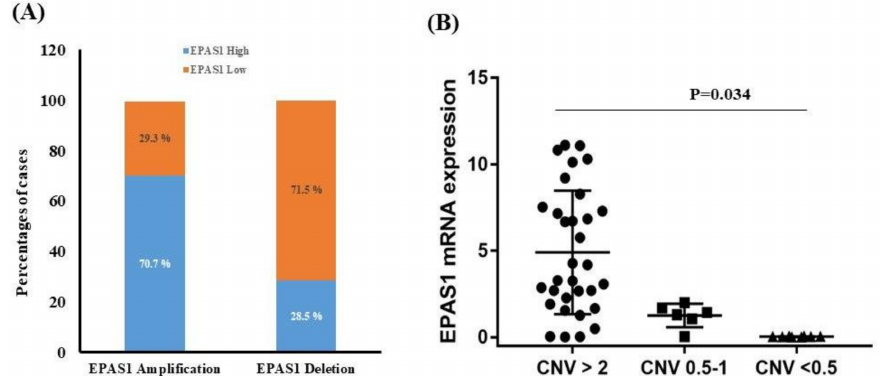
Figure 5. Relationship of EPAS1 DNA number alteration and mRNA expression. ( A ) Association of EPAS1 DNA number changes and mRNA expression. Quantitative reverse transcription polymerase chain reaction (RT-qPCR) analysis revealed that EPAS1 DNA number amplification significantly correlated with mRNA overexpression ( p < 0.009). ( B ) The distribution of EPAS1 mRNA expression in patients with phaeochromocytomas / paragangliomas with a copy number of 2 or less than 2 and greater than 2. Patients with a copy number greater than 2 had shown higher mRNA expression ( p = 0.034).